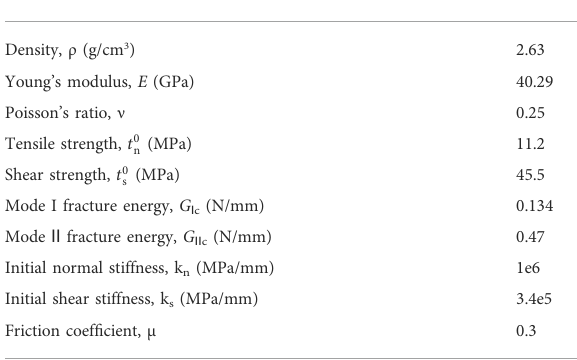
TABLE 3 Input parameters of the calibrated FDEM